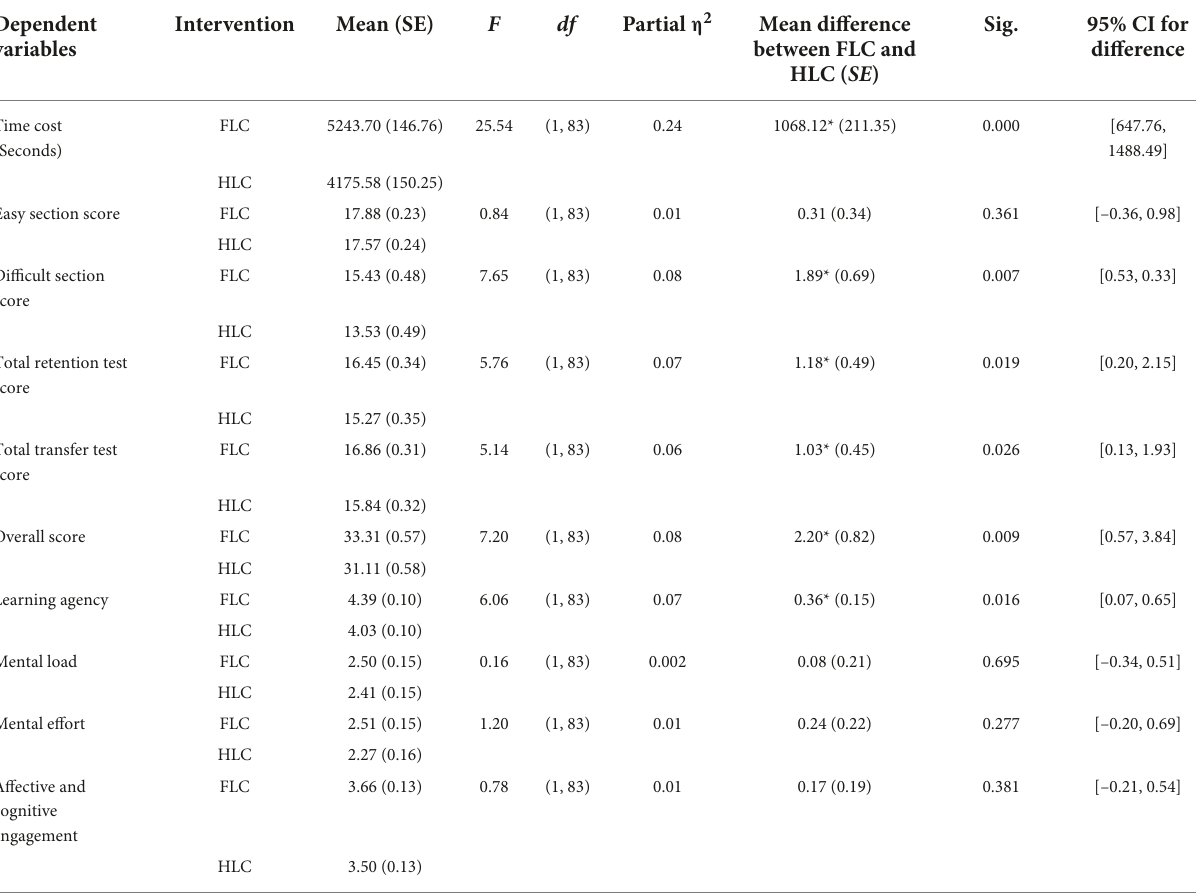
TABLE 1 Descriptive statistics and pairwise